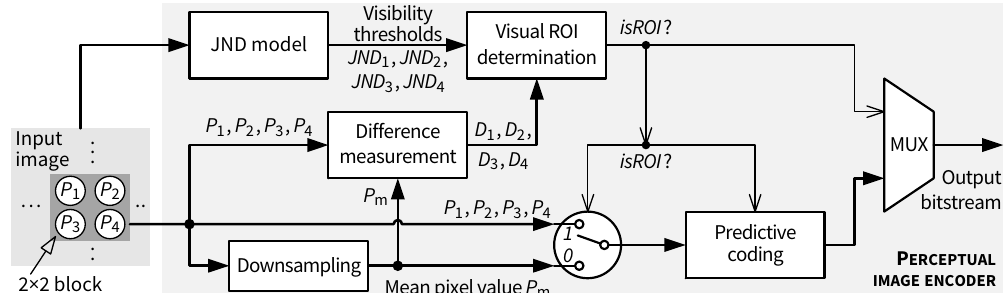
Figure 16. JND-based pixel-domain perceptual image coding algorithm proposed in [14].